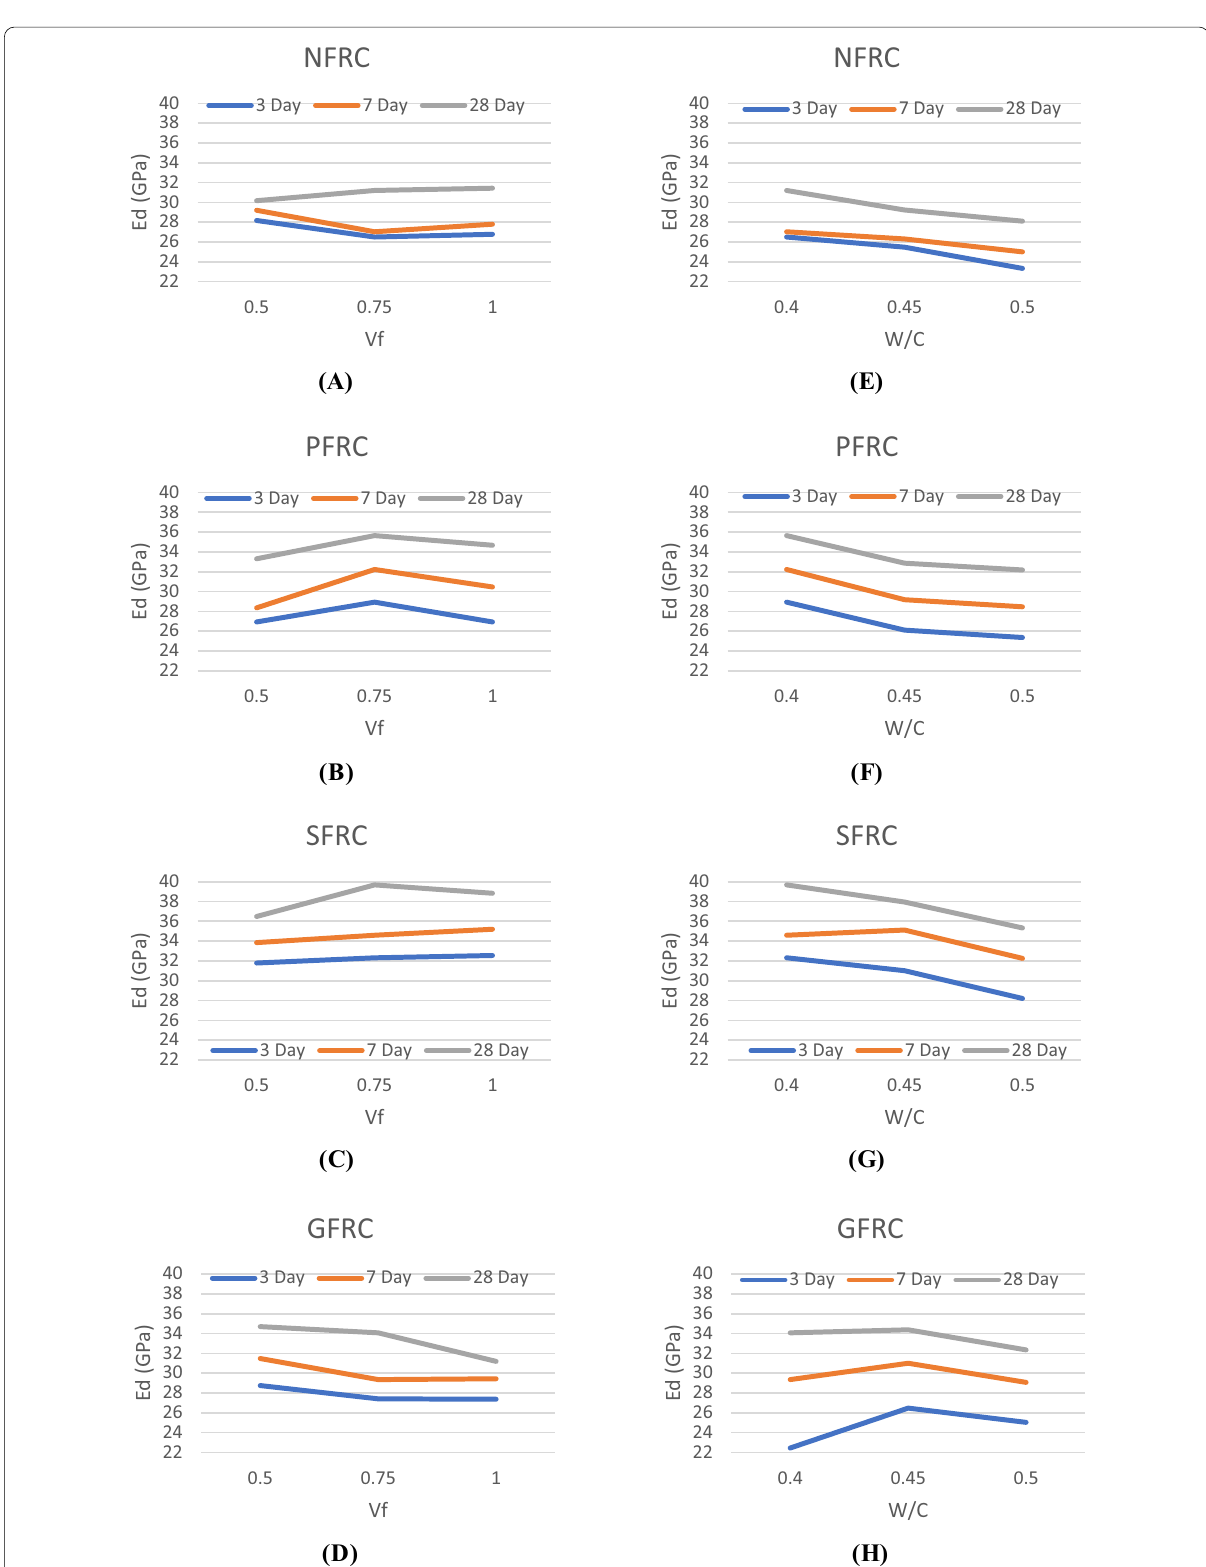
Fig. 2 A–D Effect of fiber volume percentage ( V f ) on dynamic modulus of FRC; E–H Effect of w / c ratio on dynamic modulus of